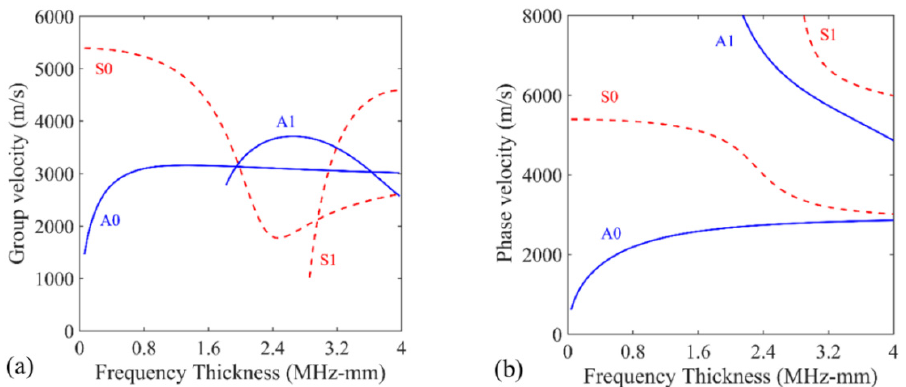
Figure 2. Dispersion curves of a 4 mm thick aluminum plate: ( a ) group velocity dispersion curves; ( b ) phase velocity dispersion curves.